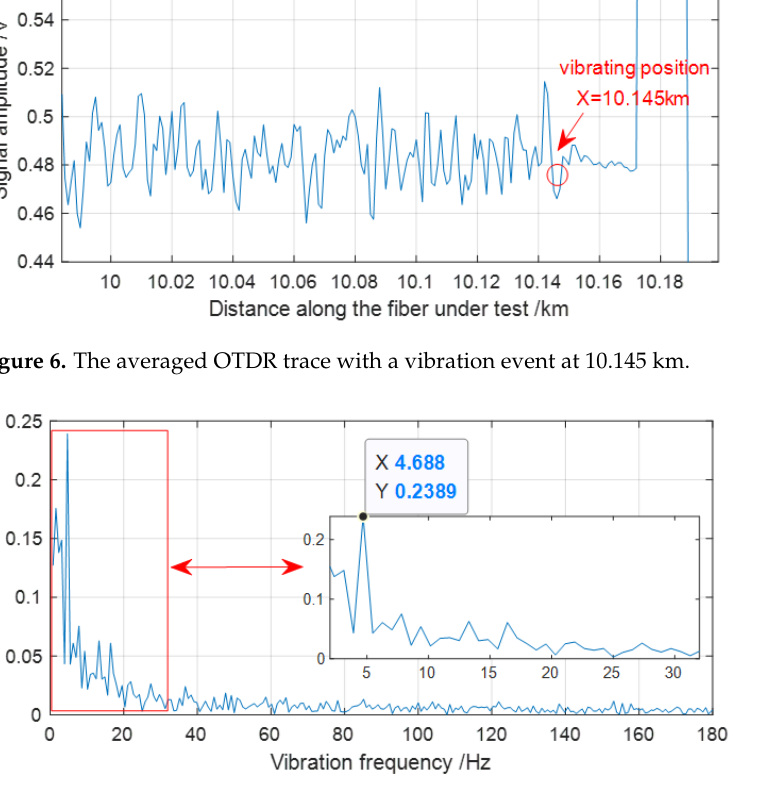
Figure 7. The spectrum of the vibration event loaded on MMF at 10.145 km.